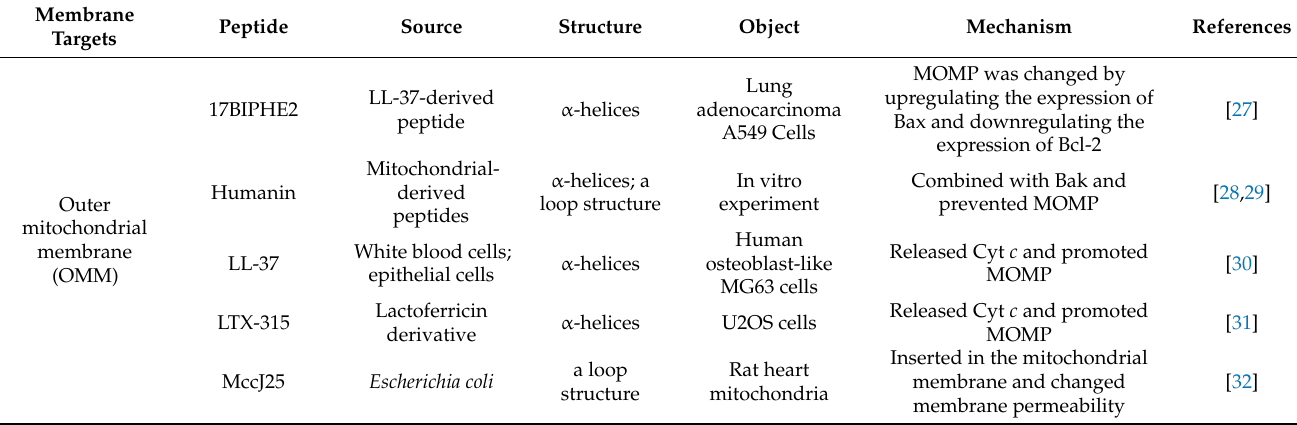
Table 1. Effect of some AMPs on the outer and inner mitochondrial